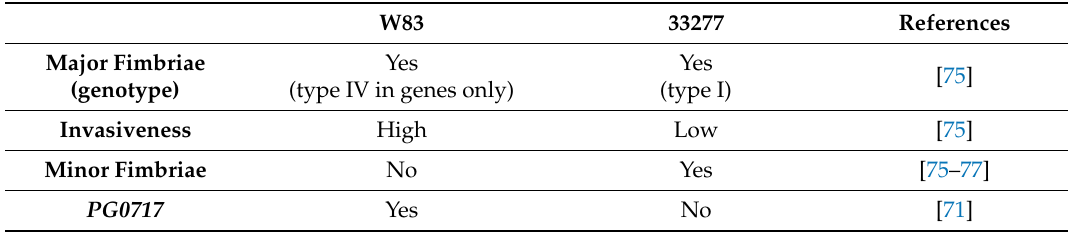
Table 1. Major genotypic and phenotypic di ff erences between P. gingivalis W83 and